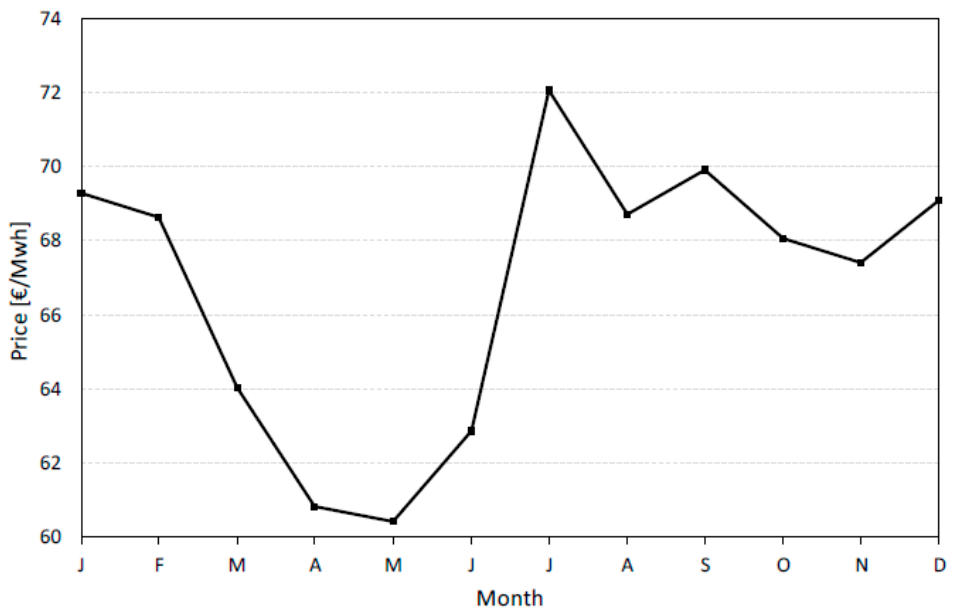
Figure 4. Average monthly Italian electricity prices obtained from historical time series 2005–2016.